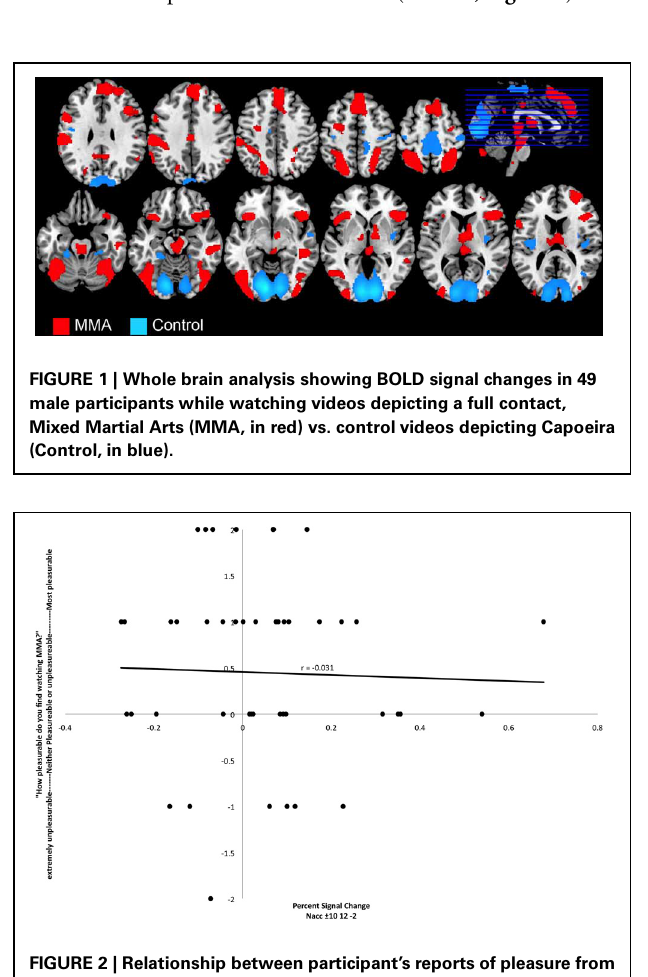
FIGURE 3 | Functional connectivity seeded in the nucleus accumbens (MNI coordinates: ± 10, 12, − 2) associated with pleasurable ratings (in red) and connectivity associated with unpleasurable ratings (in